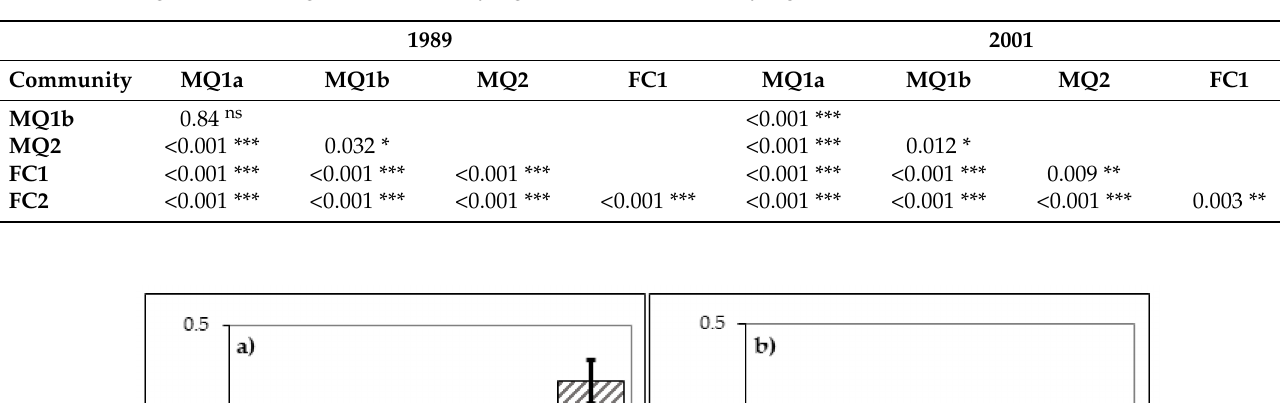
Table 5. Post Hoc pair-wise comparisons on the NDVI differences between the communities for August 2001 and June 1989. ns = Not significant, * = Significant, ** = Very significant, *** = Extremely significant.